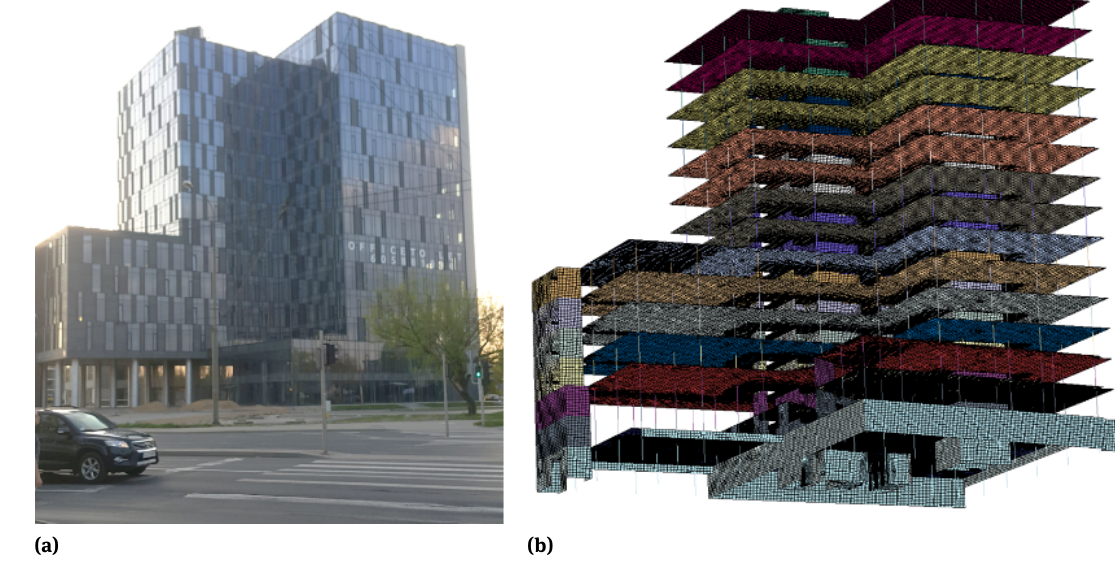
Figure 1: The analysed building: a) a perspective of the view structure, b) a 3D numerical